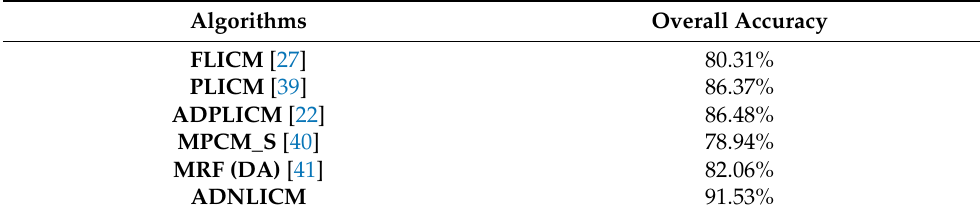
Table 16. Comparison of OA with different